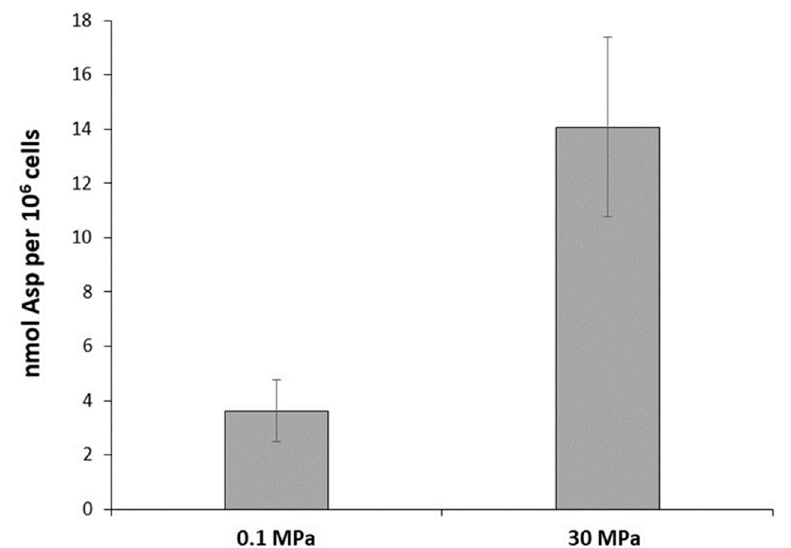
Figure 5. Intracellular aspartate concentration in P. elfii DSM9442 cultures grown at 0.1 MPa and 30 MPa. The values represent the means of assays from three independent cultures.